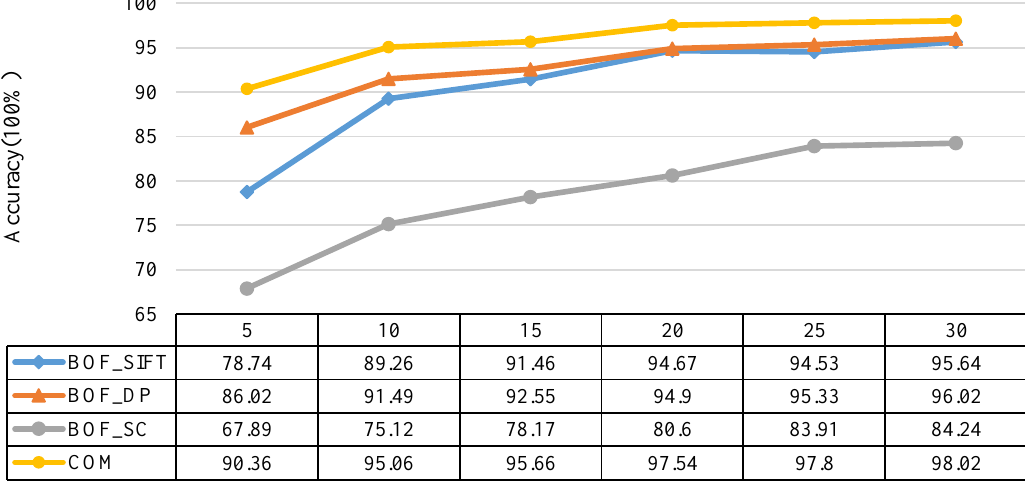
Figure 12. The relationship between the training number of each species and the recognition accuracy.